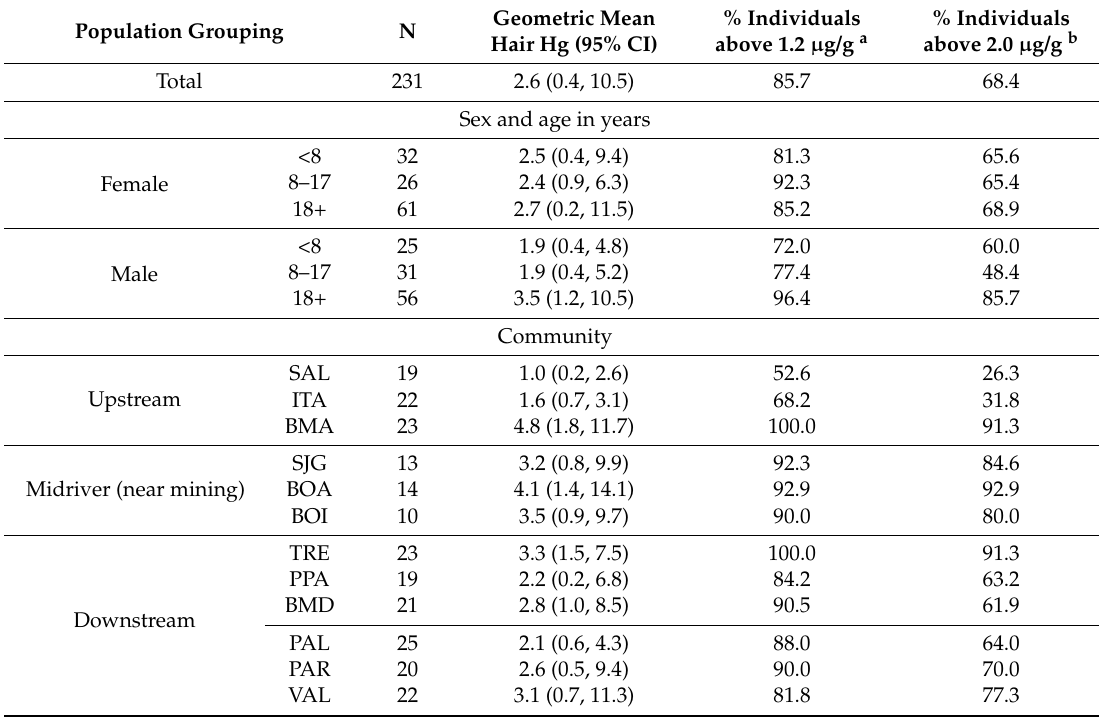
Table 1. Summary of hair mercury ( µ g/g) distribution by sex, age, and community. Population